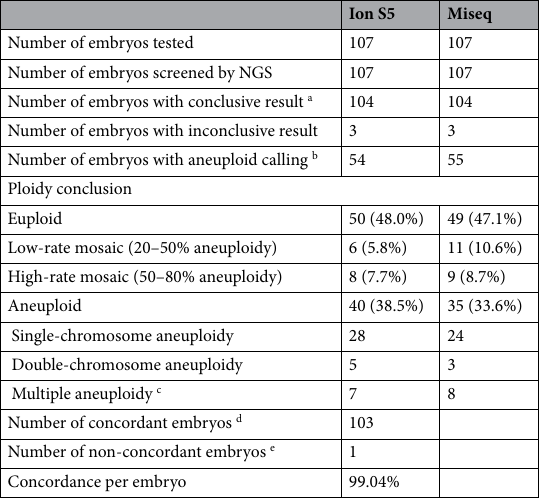
Table 2. Concordance analysis per embryo. a It excludes embryos with chaotic patterns that the ploidy could not be interpreted. b It includes embryos with mosaicism and aneuploidy. c It includes embryos with more than two aneuploid chromosome pairs. d It includes embryos identified as euploid or mosaic/aneuploid on the both two NGS systems. e Embryos identified as euploid on only one NGS system, and as mosaic or aneuploid on the other system.